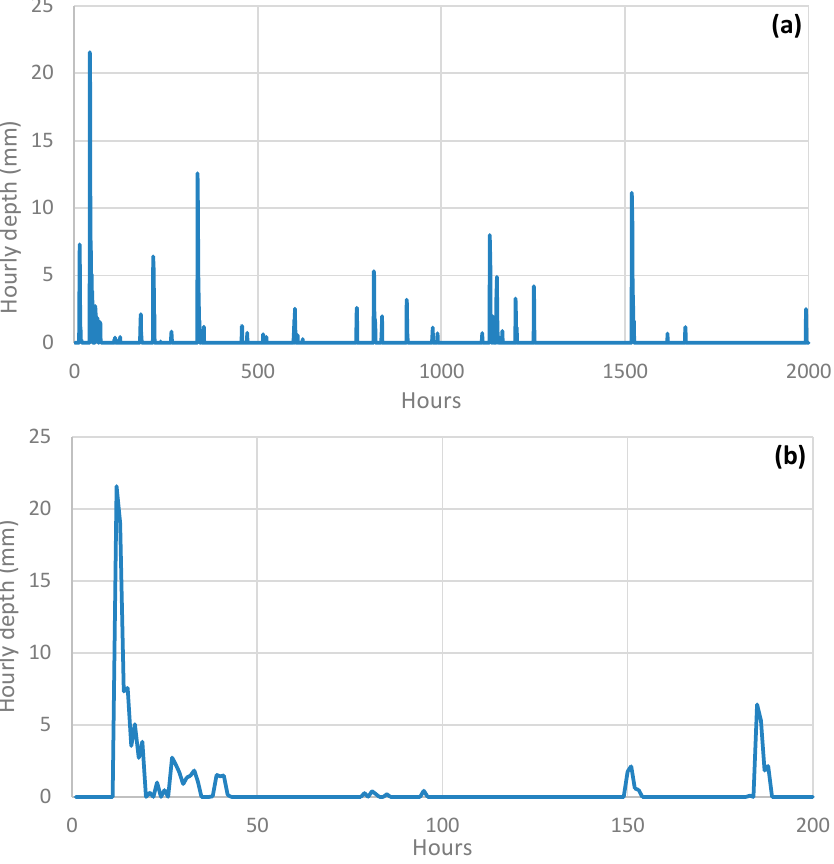
Figure 7. Plots of generated time series of precipitation in Bologna at hourly time scale: ( a ) for a period of 2000 h (83 d); ( b ) focus on the first 200 h (~8 d).